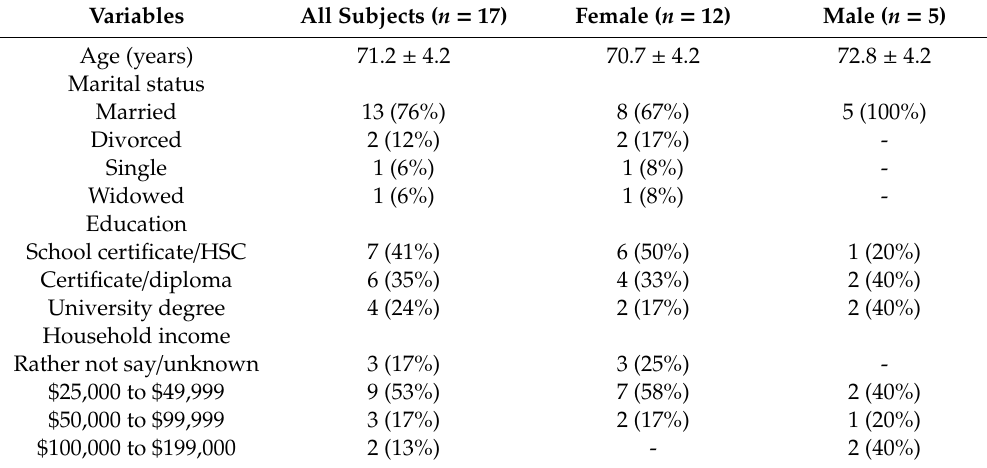
Table 1. Participant